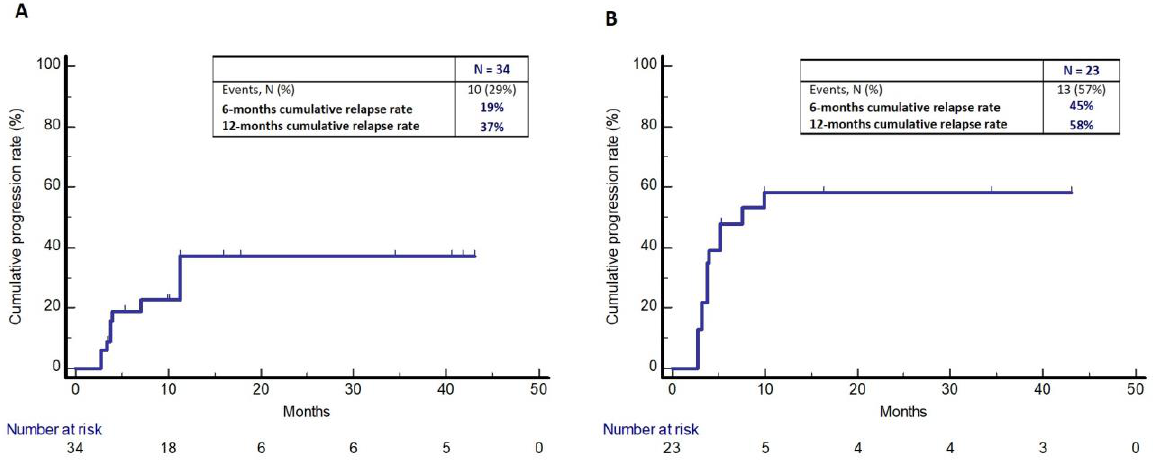
Figure 4. Cumulative progression rate of RTLM ( panel A ) and SRLM ( panel B ).